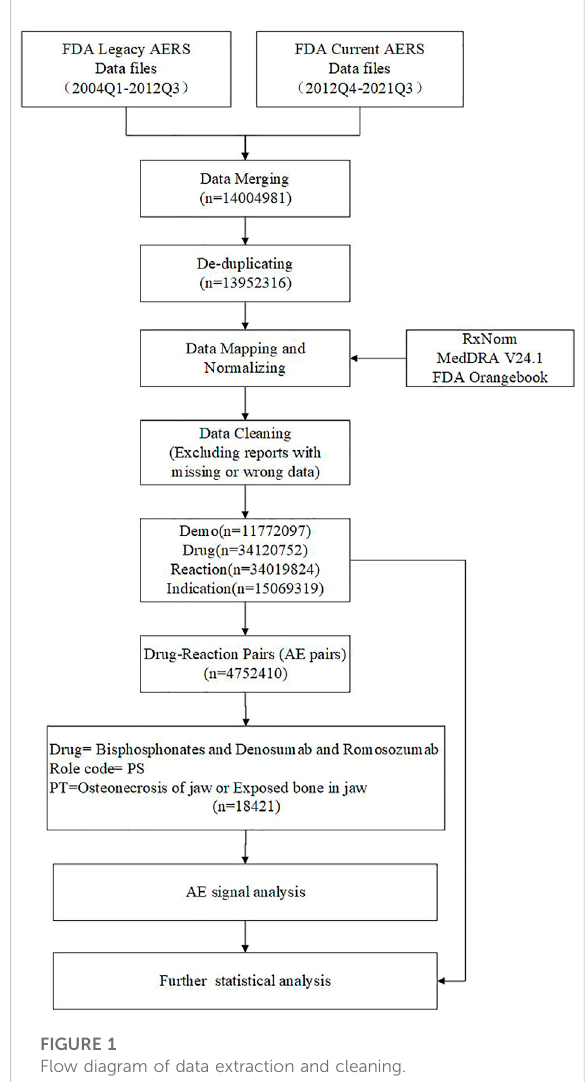
FIGURE 1 Flow diagram of data extraction and